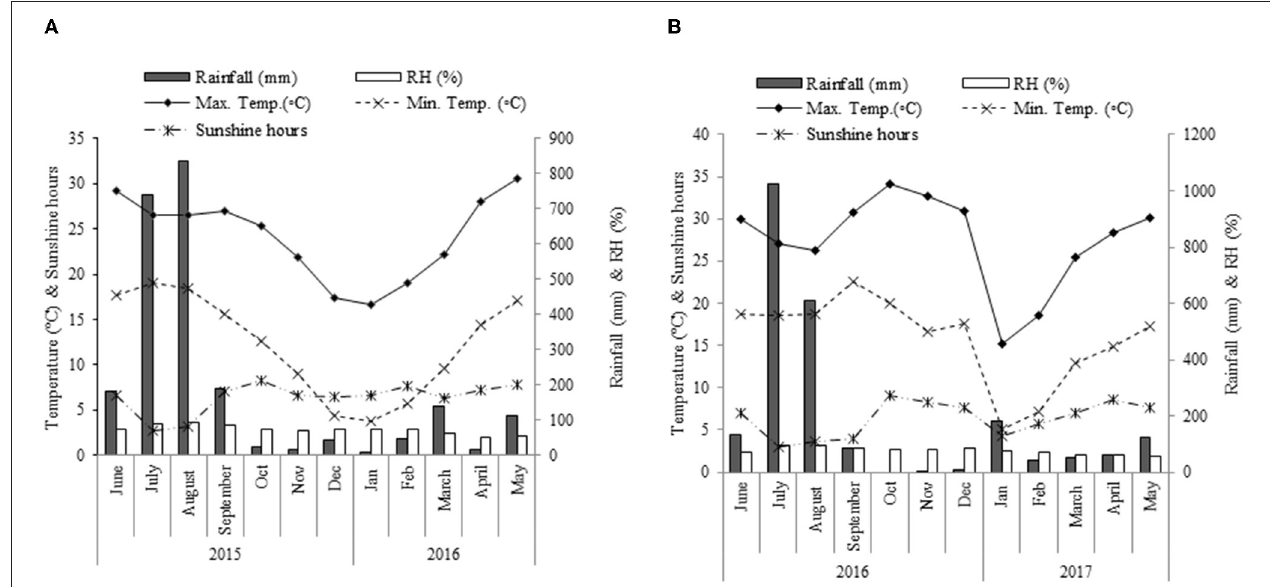
FIGURE 1 | Monthly mean temperatures ( ◦ C), sunshine hours (SS), rainfall (mm), and relative humidity (RH) during the cropping season of 2015–2016 (A) and 2016–2017 (B) at Palampur,